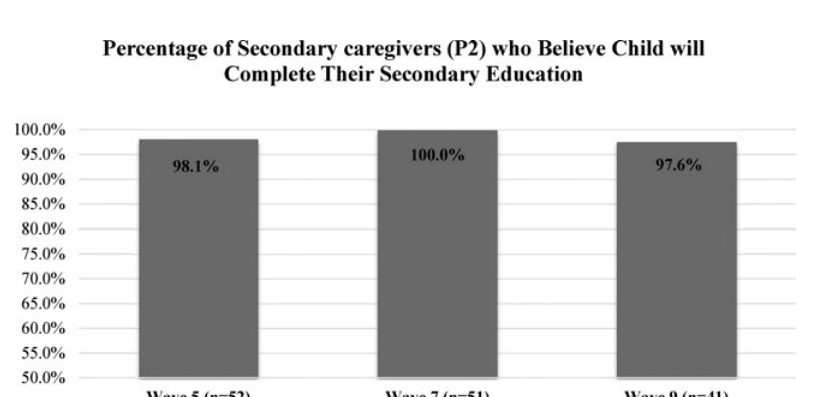
Fig. 4. Secondary caregiver (P2) expectations regarding their children completion secondary education.